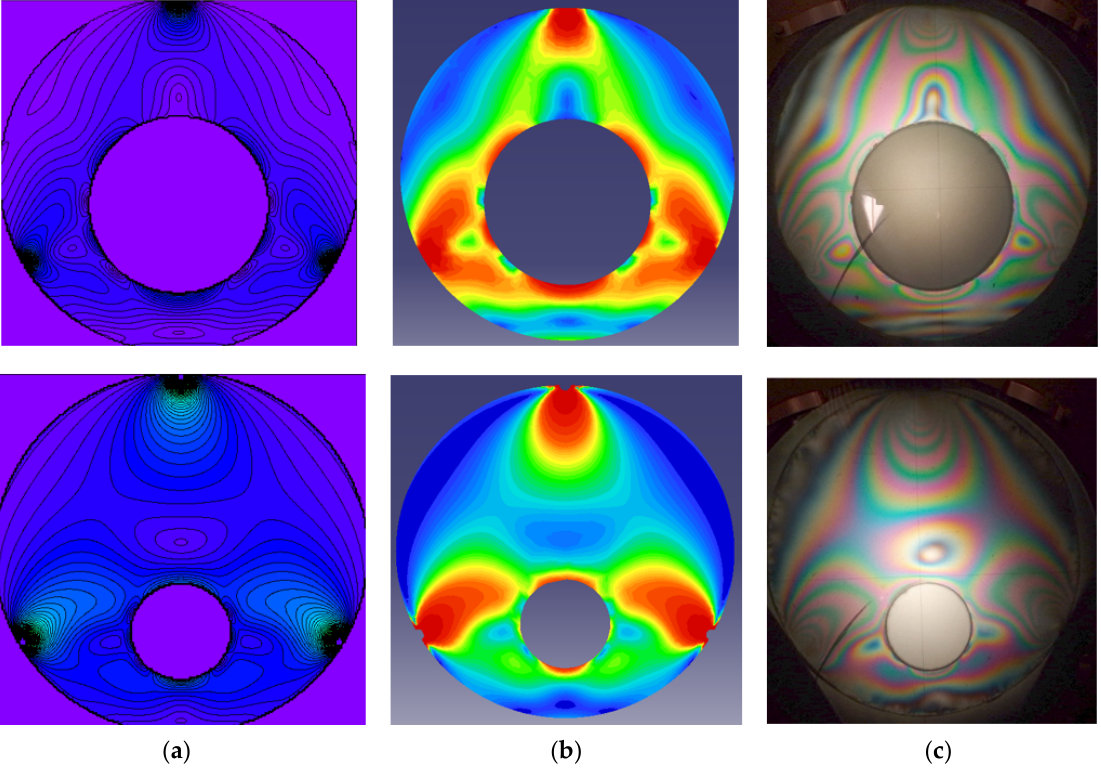
Figure 17. Isochromatic fields for two geometries of the ring compressed by three equidistant forces (loading Case d , Table 1): theoretical ( a ), numerical ( b ) and experimental ( c ) results.